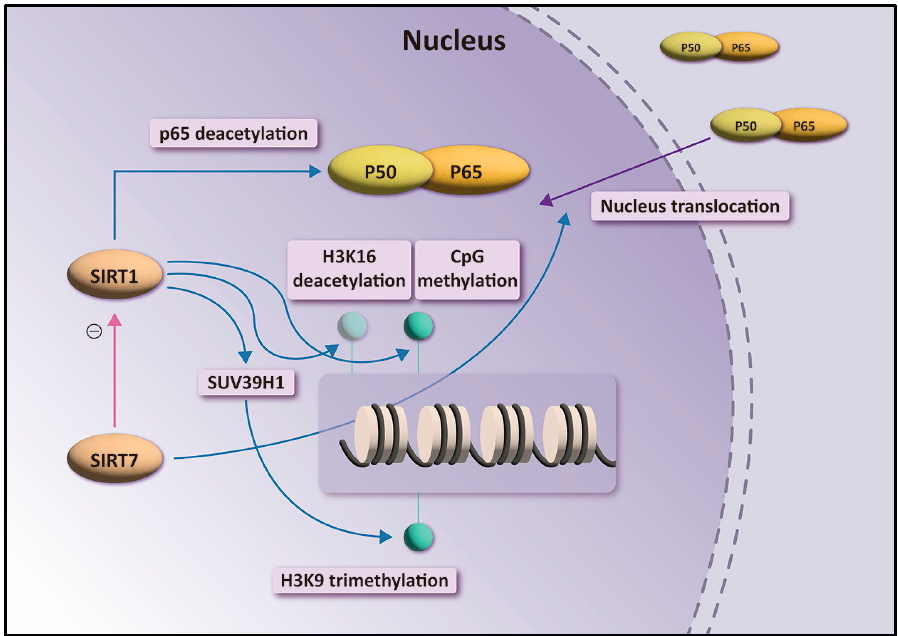
Figure 5. Overview of the role of SIRT1 and SIRT7 in the transactivation of NF- κ B-dependent gene expression.